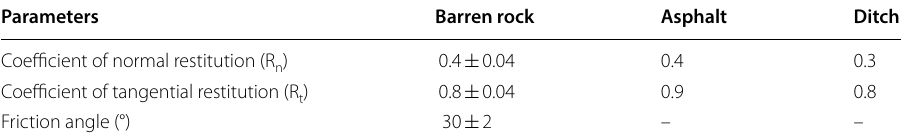
Table 2 Used parameters for the rockfall analysis Parameters Barren rock Asphalt Ditch Coefficient of normal restitution (R n )